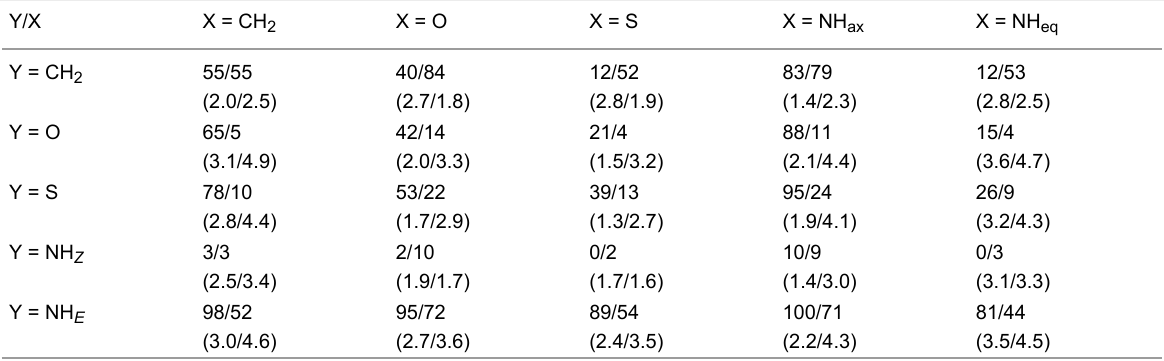
Table 1: Gibbs population (%) for the axial conformer (at 298 K and 1 atm) in vacuum/DMSO. a